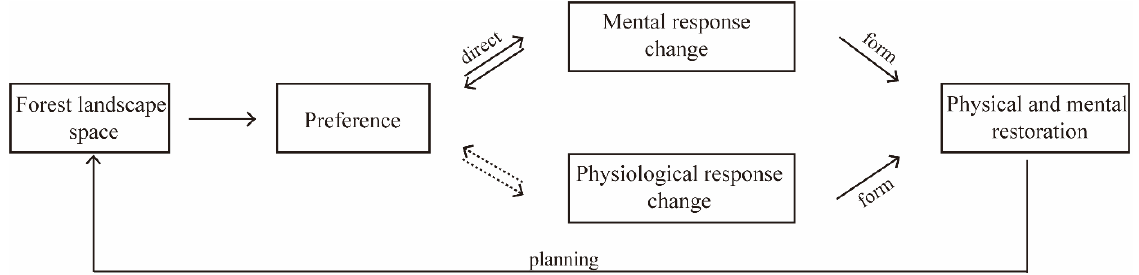
Figure 9. Relationships between participants ’ preference and physical and mental restoration in forest landscape space.